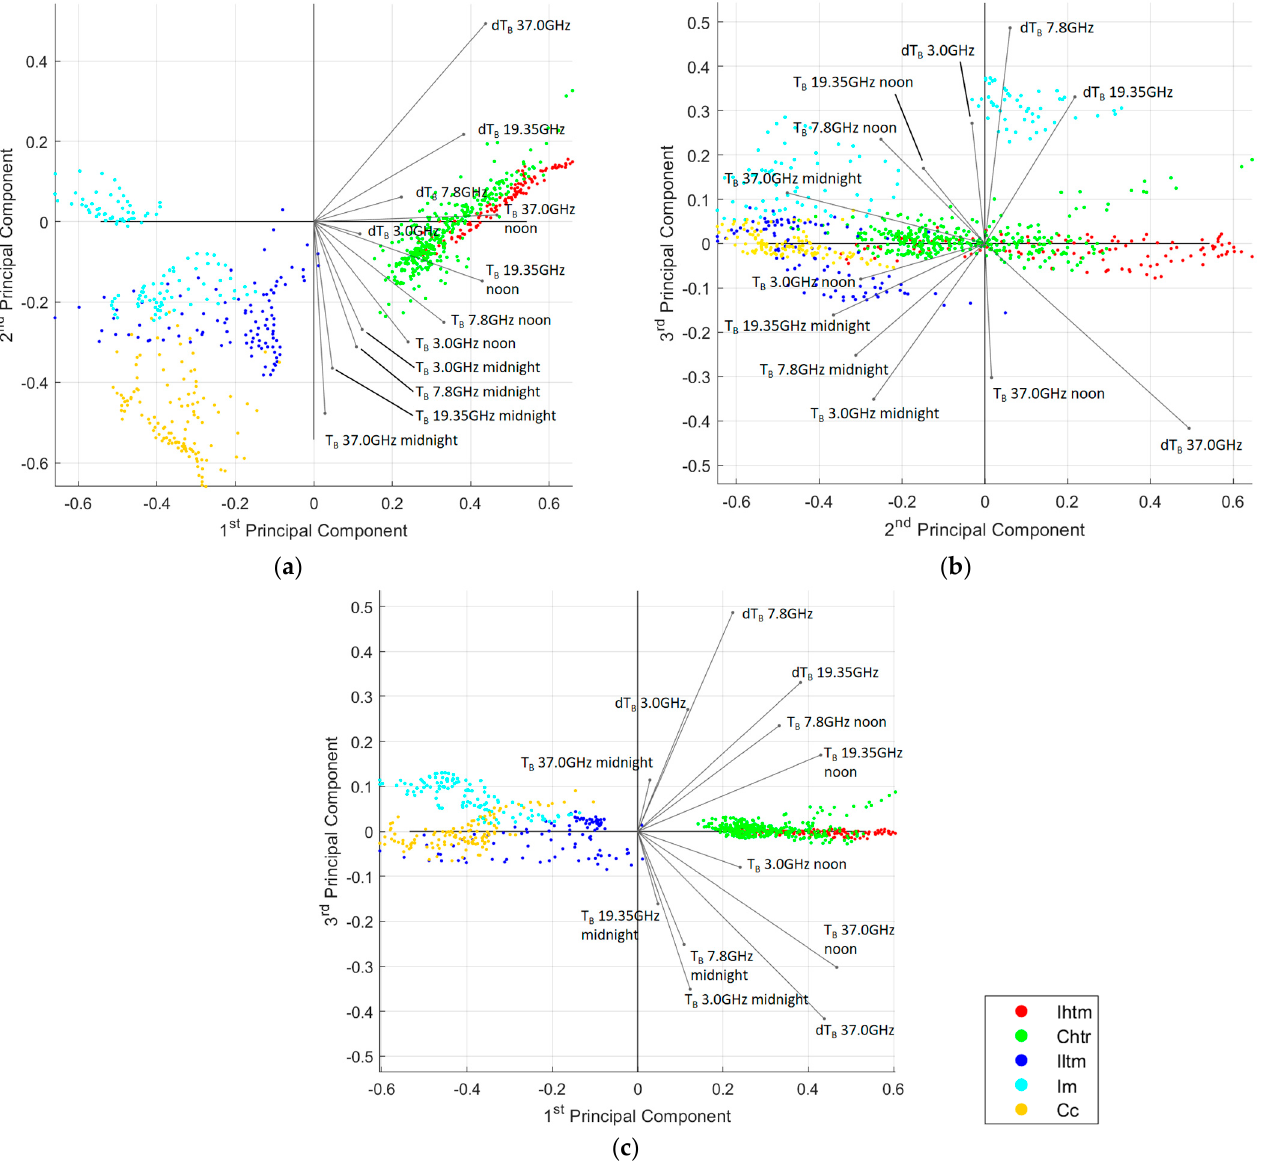
Figure 14. PCA space of dimension-reduced brightness temperature features. ( a ) Biplot of the 1st – 2nd PCs; ( b ) Biplot of the 2nd – 3rd PCs; ( c ) Biplot of the 1st – 3rd PCs.